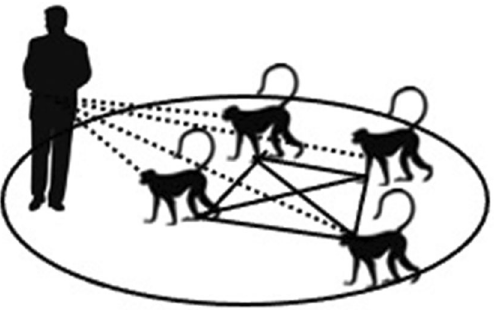
Figure 1. The assignment of edge (solid lines) for macaques’ human co-interaction networks, based on their co-occurrence and joint interactions with humans (dotted lines) within the same time (10-min time-frames) and space (pre-defined blocks of anthropogenic features within the macaques’ home-ranges) (more details in 43